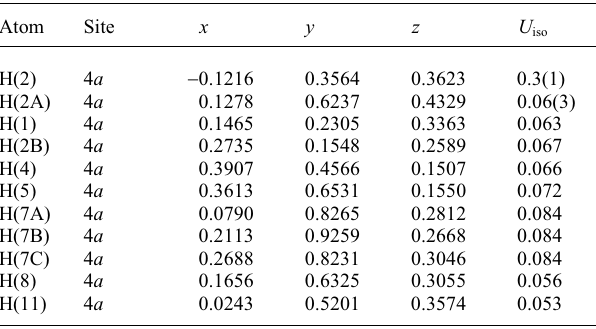
Table 2. Atomic coordinates and displacement parameters (in Å 2 )